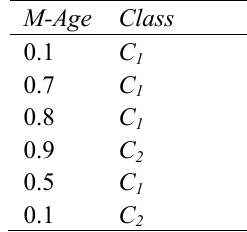
Table 6: Part of a Database Containing